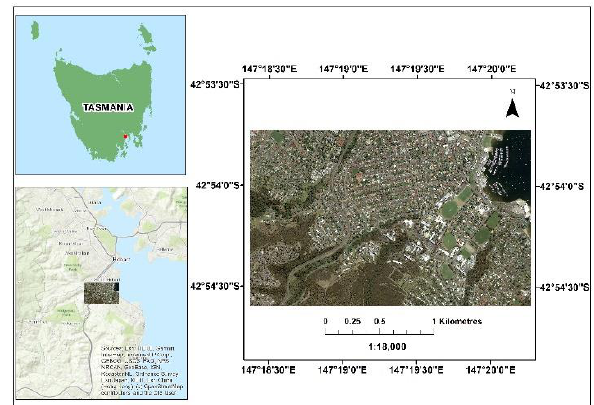
Figure 2. Location of study area, which is located within Sandy Bay Hobart (42.904549ºS, 147.328536ºE) and has an area